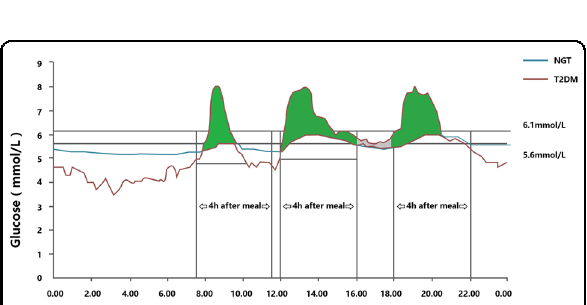
Fig. 2 Calculation used for the AUC under condition B. If the glucose pro fi le was under the baseline, ascondition B. AUC-T was only calculated using glucose values above the baseline criteria, and the area below the baseline point was not included in the calculation of overall hyperglycaemia. The green part represents AUC-PPG. The gray part represents AUC-BG (AUC-T –